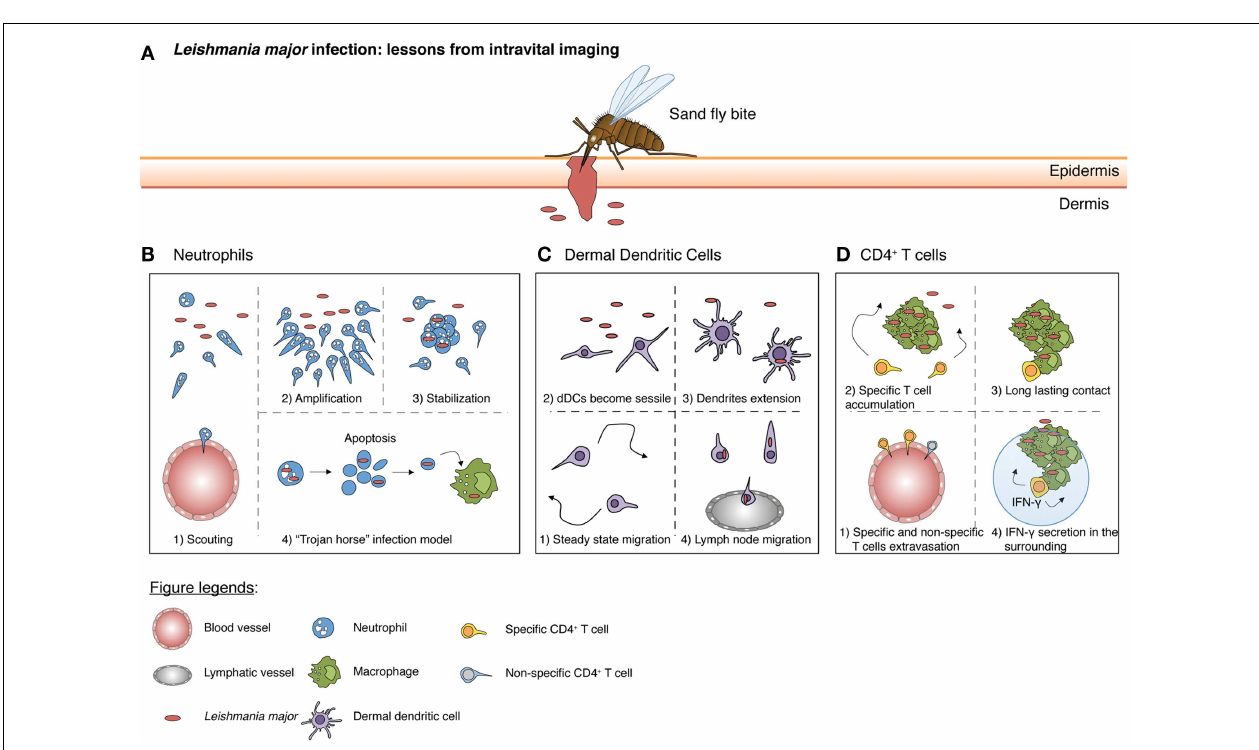
FIGURE 2 |A schematic summary from intravital imaging studies illustrating the responses initiated by different immune cells during Leishmania major infection . (A) A sandfly bite creates a hemorrhagic pool and damages both the epidermis and dermis of the host. During a blood meal, parasites are then introduced into the dermis. (B) At the early stages, few scouting neutrophils are recruited at the lesion site (scouting phase) where parasites are localized. Subsequently, more neutrophils swarm toward the scouting neutrophils (amplification phase). Neutrophil clustering occurs, followed by stabilization (stabilization phase). Concurrently, neutrophils actively phagocytose the parasite. Neutrophils would eventually die by apoptosis and these infectious apoptotic bodies, containing Leishmania major (L. major), are scavenged by macrophages (“Trojan horse” model). (C) At